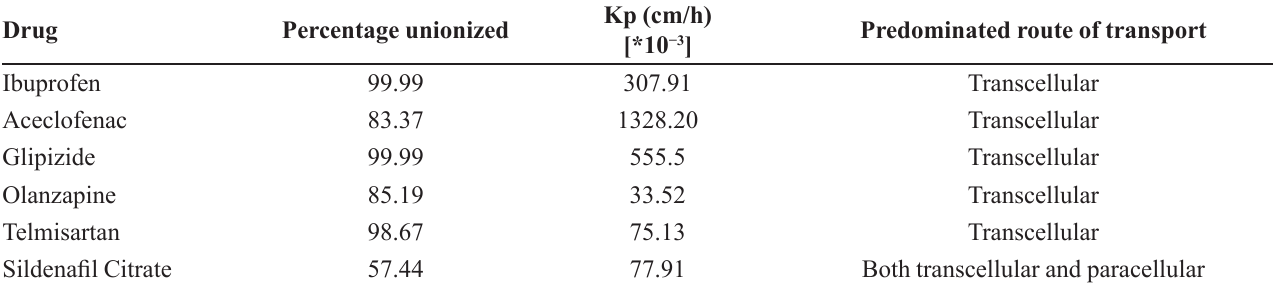
TABLE VII - Preferred route of drug permeation